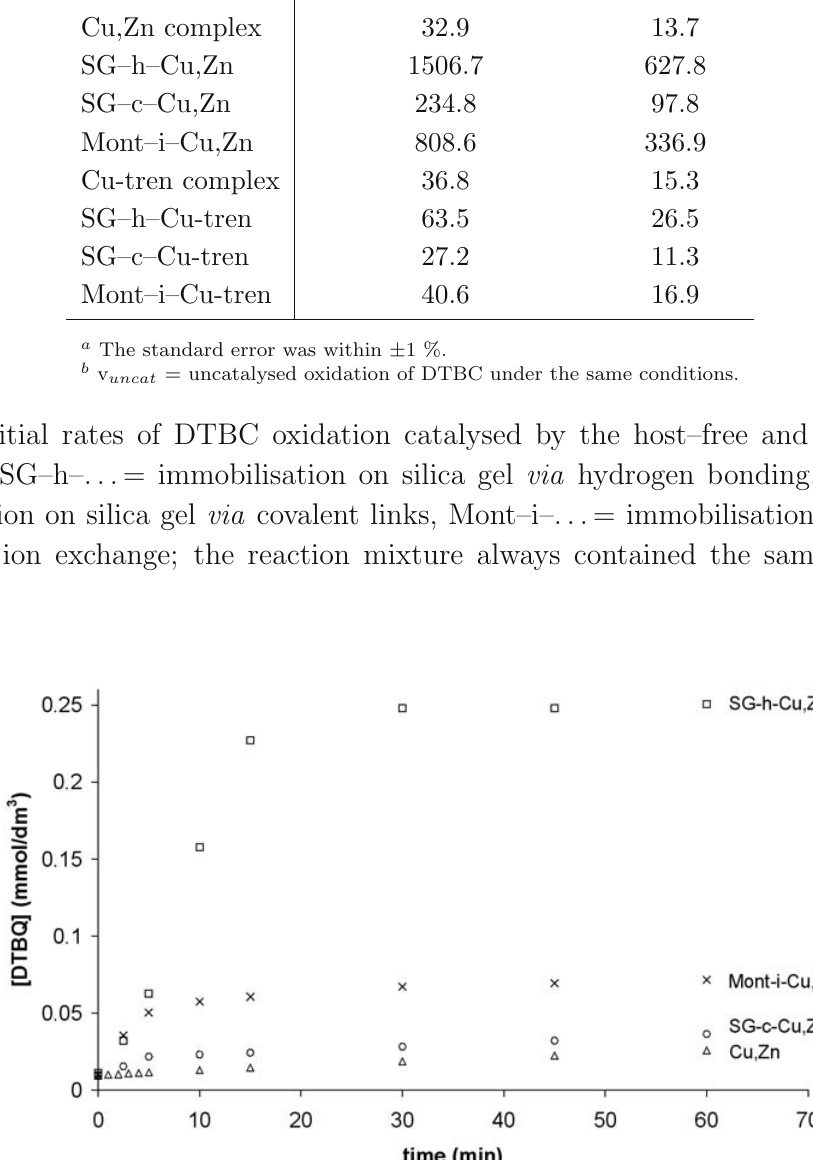
Fig. 8 Catecholase activity of the Cu,Zn complex and its immobilised forms described by the concentration of DTBQ versus time plot ([DTBC]=10 mM, [Cu 2+ ]=0.1 mM, T=298